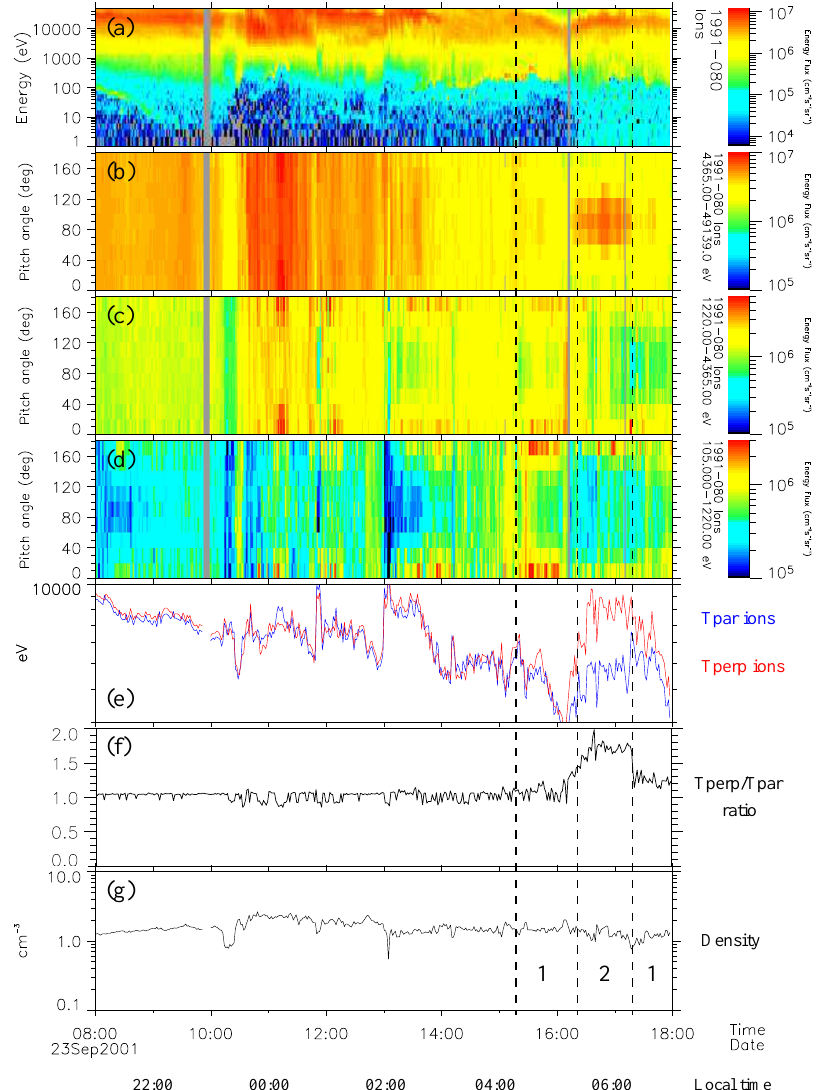
Fig. 7. Los Alamos spacecraft 1991-080 data for the interval 08:00–18:00 UT on 23 September 2001. Panel (a) shows the omni-directional energy flux spectra for the ions. Panels (b) , (c) and (d) display the pitch angle spectra of the ions for the energy ranges 4365–49139, 1220–4365 and 105–1220eV, respectively. The magnetic field direction was found by use of the ion pressure tensor, assuming gyrotropy. Panel (e) shows the measured parallel and perpendicular ion temperatures. Panels (f) and (g) display the parallel-to-perpendicular ion temperature ratio and the ion density, respectively. Regions 1 and 2, in panel (g), are described in the text. Universal and local times are shown at the